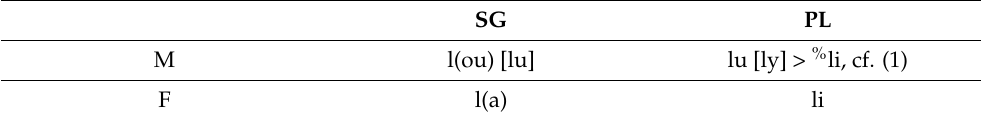
Table 2. Paradigm of Nissart definite articles.